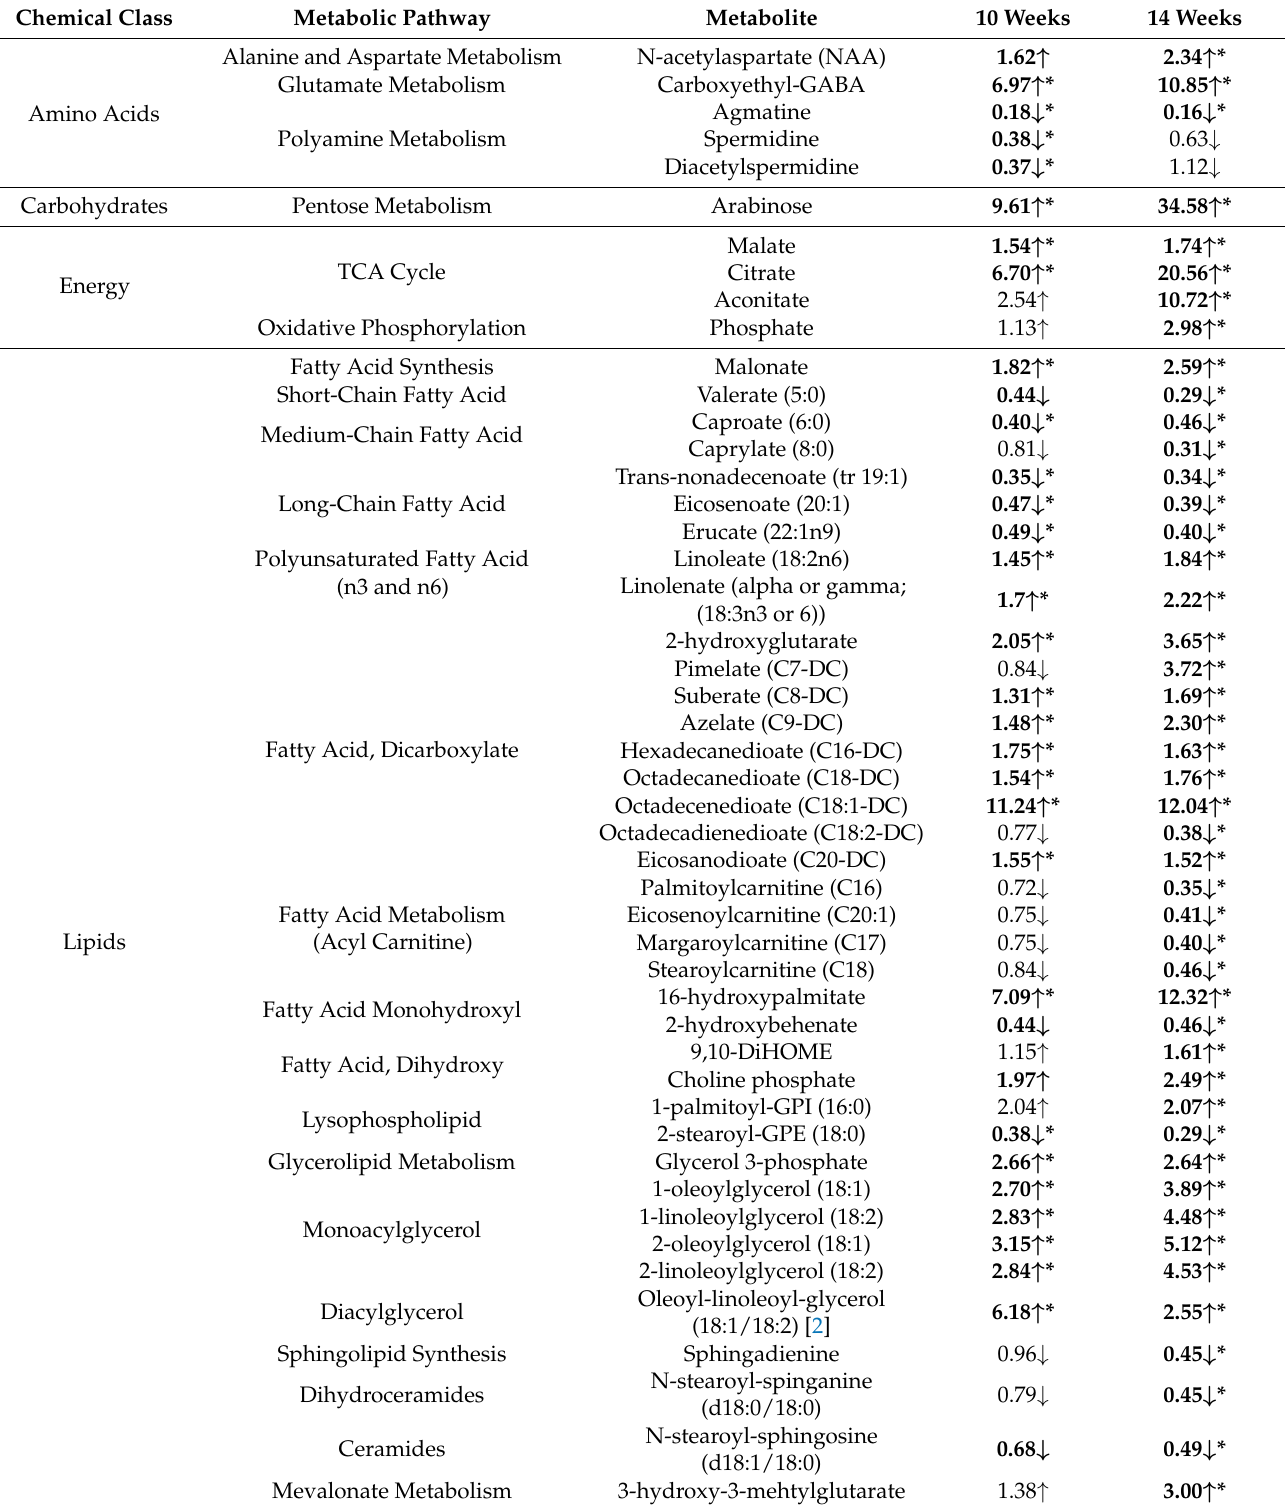
Table 1. Fold differences in the median scaled relative abundances between the AOM/DSS rice bran group versus control mice at weeks 10 and 14. Metabolites with a fold difference cut-off of >1.5 or <0.5 are shown for either week 10, 14, or